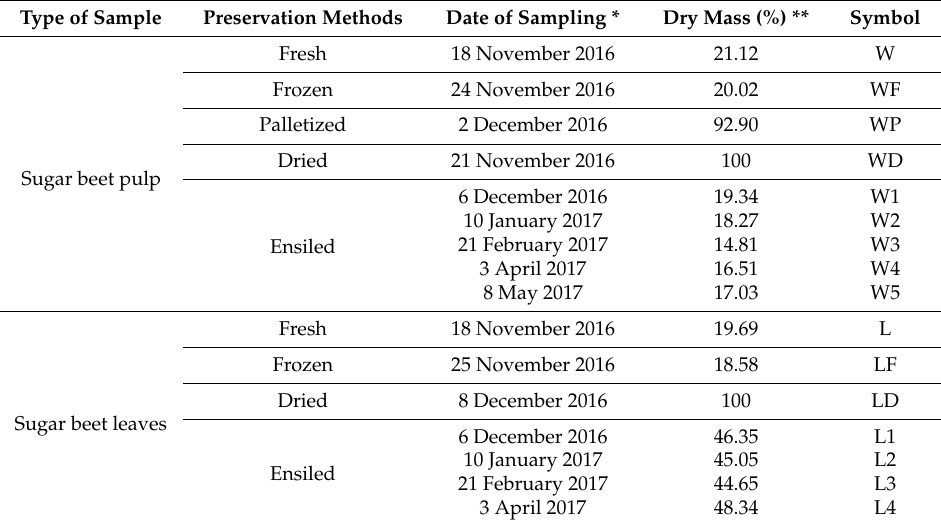
Table 9. Biomass used in the